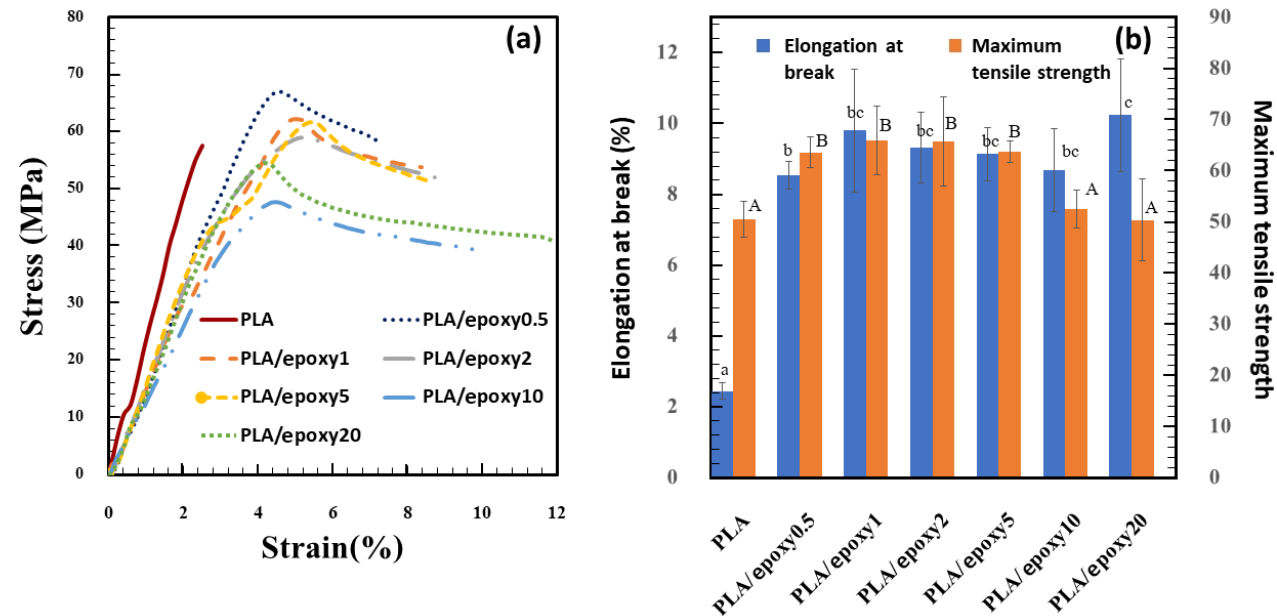
Figure 1. Tensile properties of PLA blend with 0–20% epoxy ( a ) Stress–strain curve, and ( b ) Maximum tensile strength and elongation at break. The different of each lowercase and each uppercase letters indicate the mean values of the elongation at break and the maximum tensile strength differ significantly ( p < 0.05), respectively.